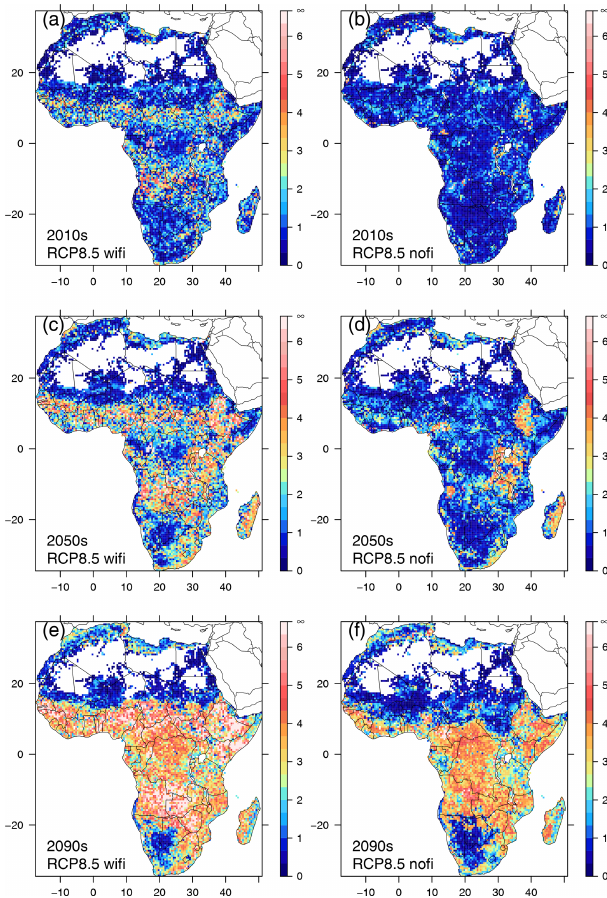
Figure 3. Spatial patterns of Euclidean distance between same- decade partners (SDPs) in RCP8.5 for three selected decades (2010–2019, 2050–2059, 2090–2099). Panels (a) , (c) , and (e) rep- resent distances between SDPs in simulations including fire (wifi), (b) , (d) , and (f) show results from simulations excluding fire (nofi).